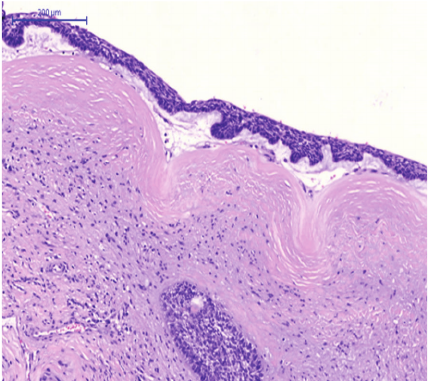
Figure 5: HE-staining. Large hepatic bile duct with dysplastic